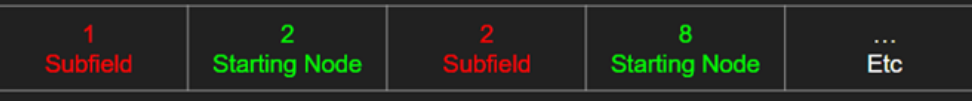
Figure 14. Chromosome structure used by the GA.